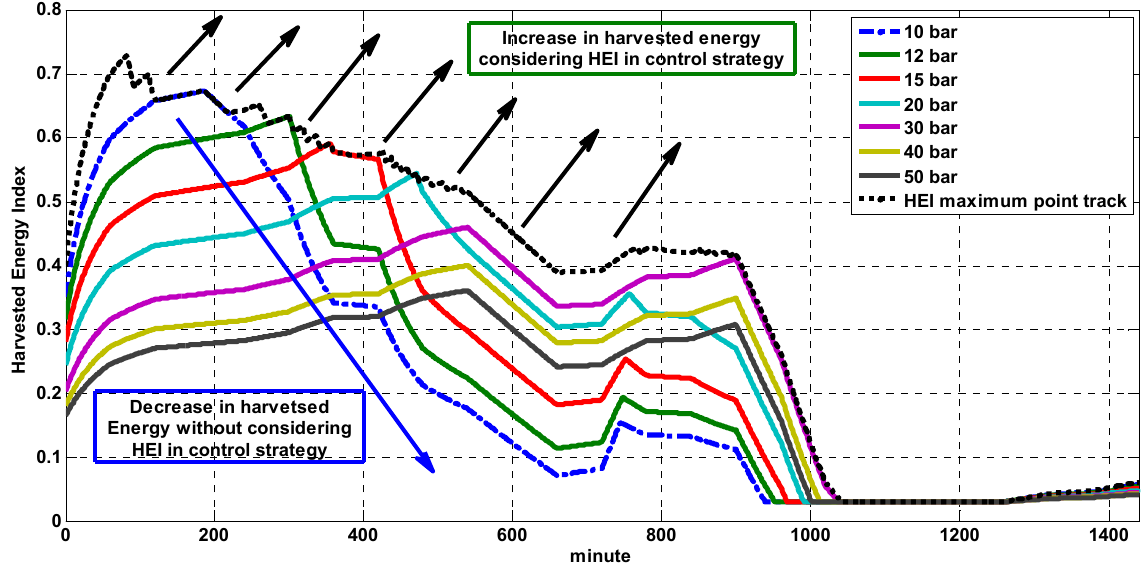
Figure 9. The calculated harvested energy index in different working